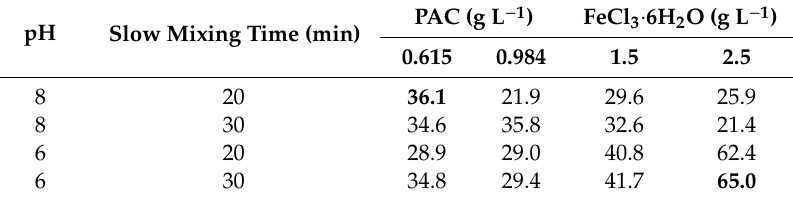
Table 2. E ff ect of coagulant dose, pH, slow mixing time when it is applied to raw landfill leachate. Factorial design 2 3 matrix of coagulation / sedimentation experiments. Results in % COD reduction.